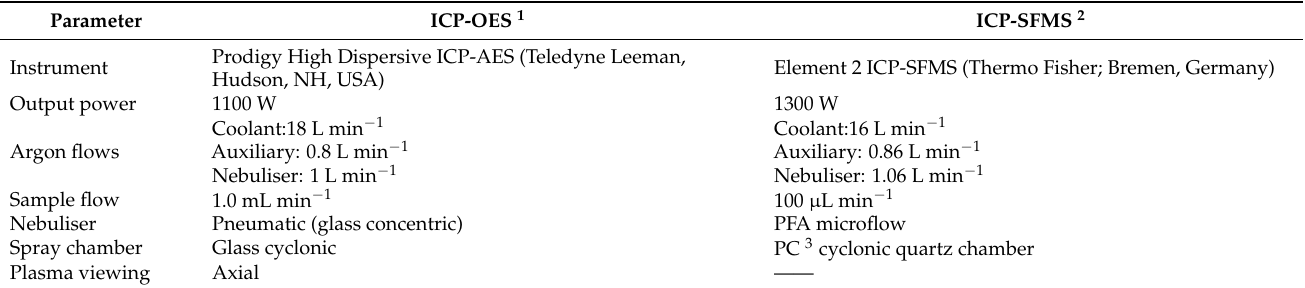
Table 4. Instrumental conditions for both analytical methods